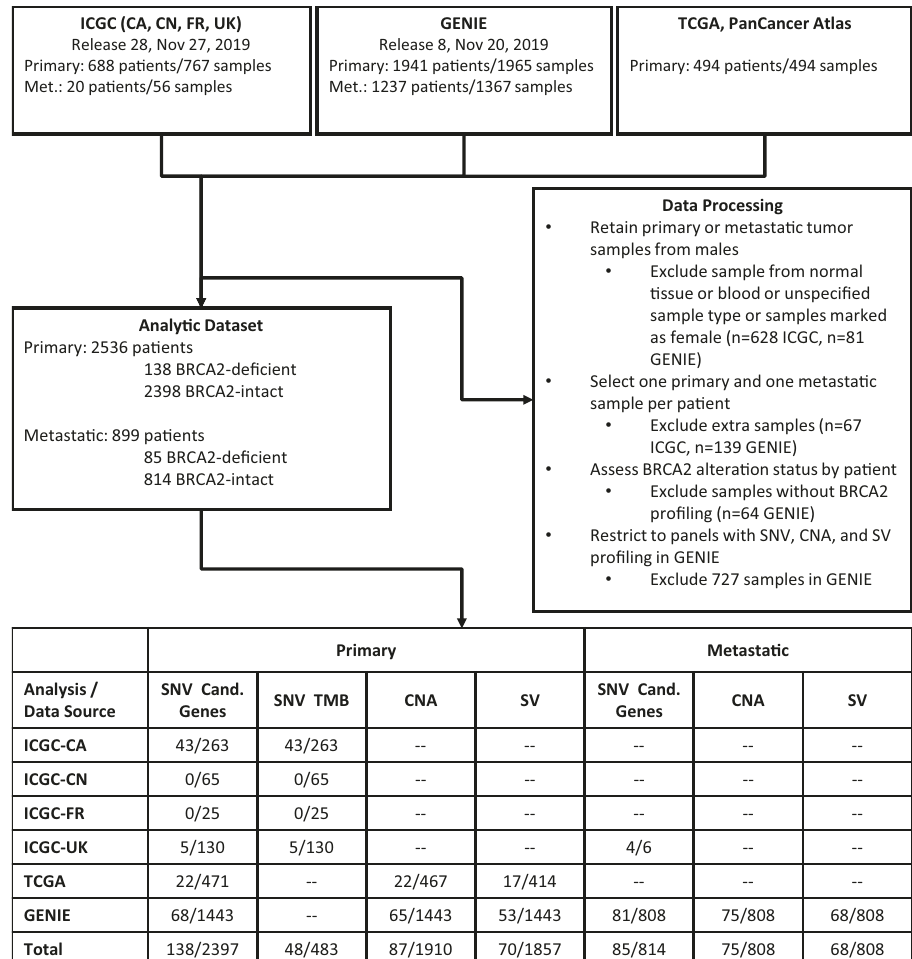
Fig. 1 Diagram of work fl ow and data processing steps to generate analytic datasets. Bottom table displays number of samples ( BRCA2 d samples/ BRCA2 i samples) included in each analysis. BRCA2 d BRCA2 -de fi cient; BRCA2 i BRCA2 -intact; Cand. Gens Candidate